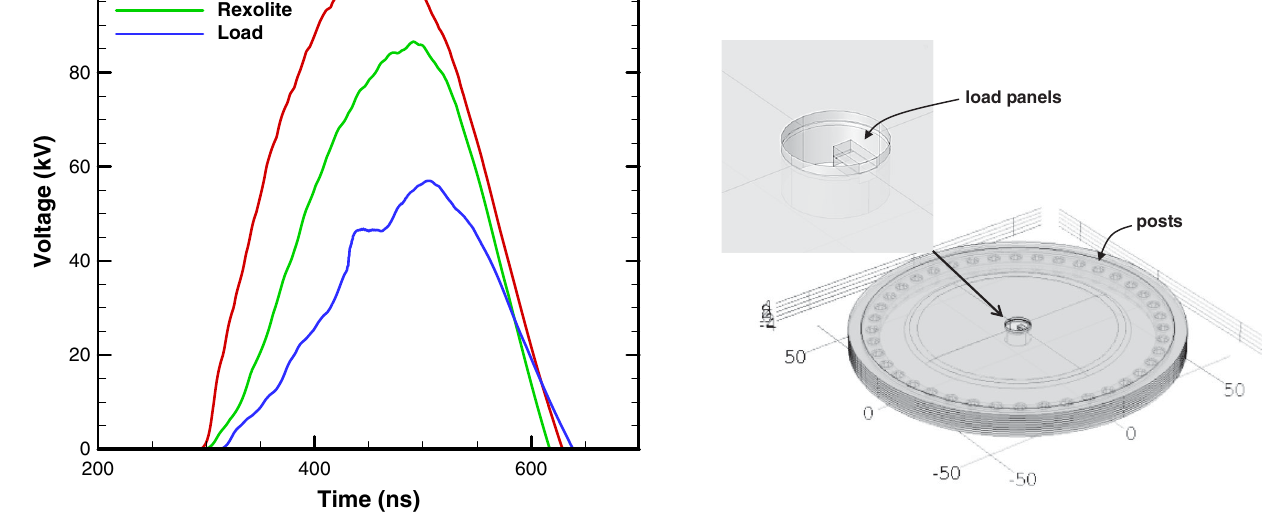
FIG. 6. Voltage waveforms for various regions of the CPF.